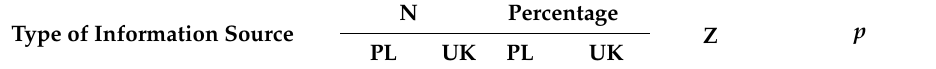
Table 3. Prominent sources of food and nutrition-related information for the UK and PL samples— fractions of groups, two-proportions Z-test statistics and p